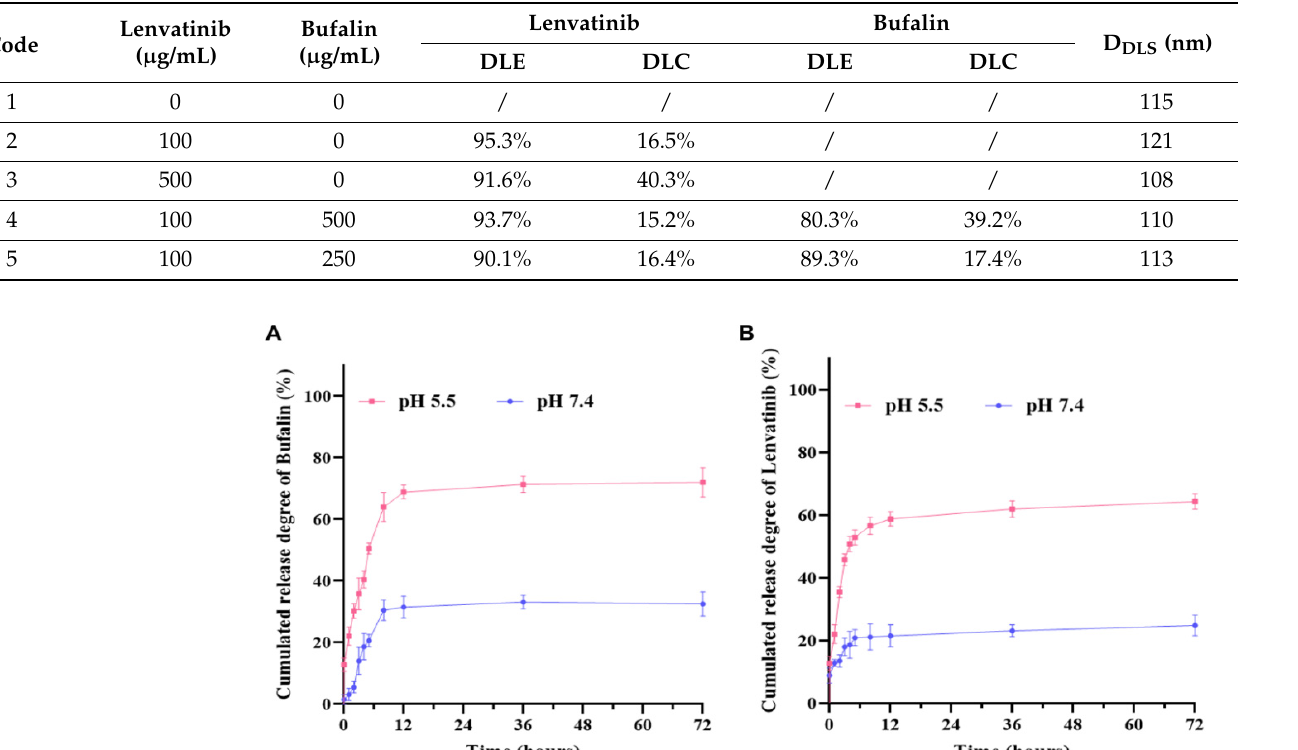
Table 2. Drugs loading data and characterization of the drug loaded mSiO 2 -FA nanoparticles.